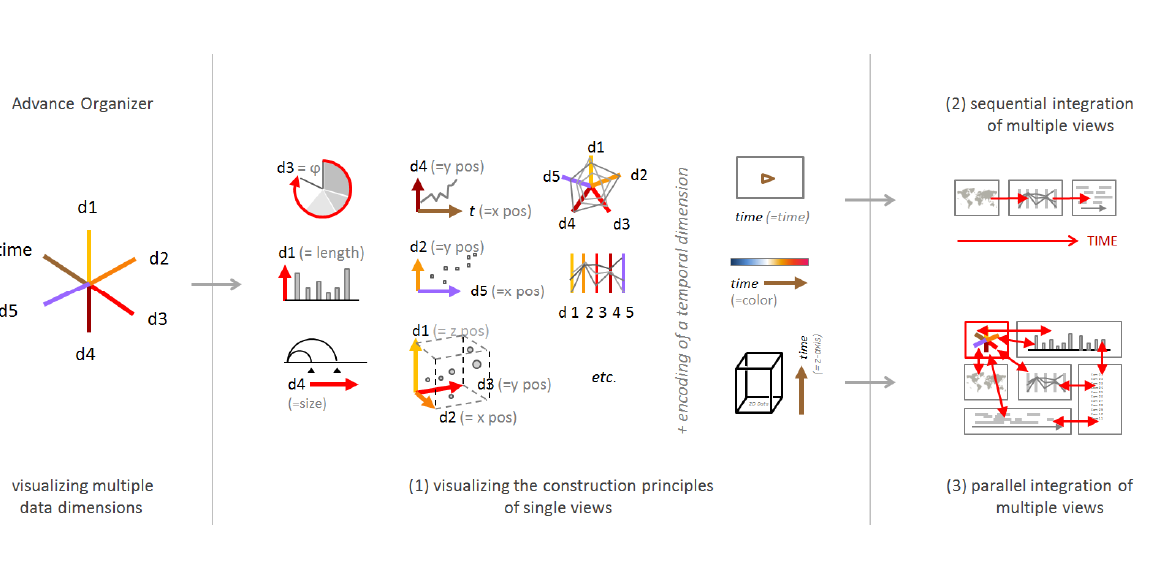
Figure 1: Tracing the incremental transformation of multiple data dimensions from an advance organizer (left), into standard forms of diagrams or single views (center), to be integrated into more complex mental models sequentially (top right) or synchronously as multiple coordinated views (bottom